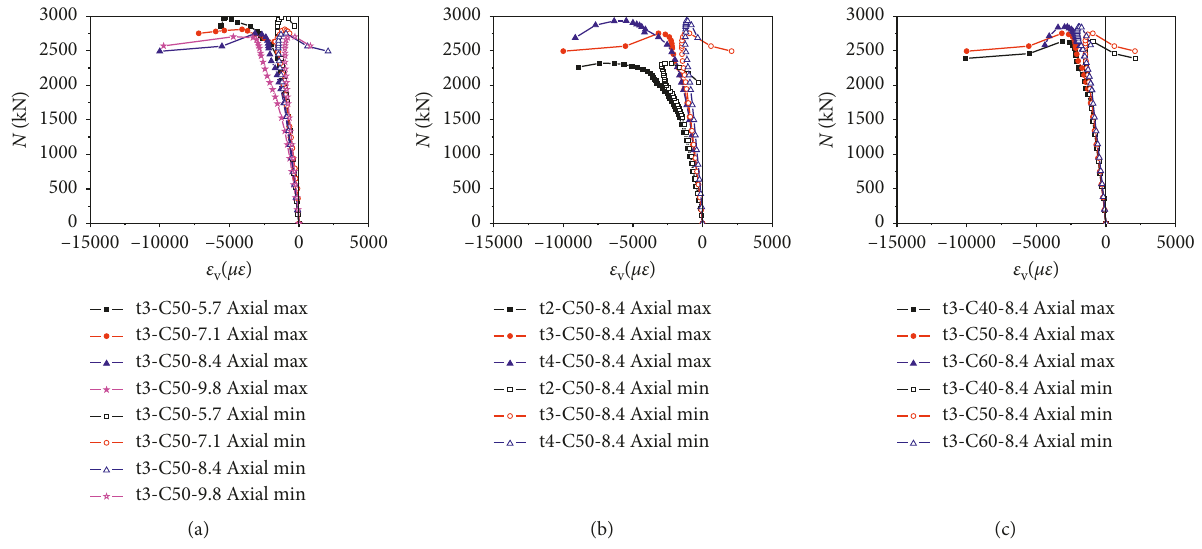
Figure 5: Axial load-axial strain of outer steel tube response. (a) L / D ratio. (b) D / t ratio. (c) SCC